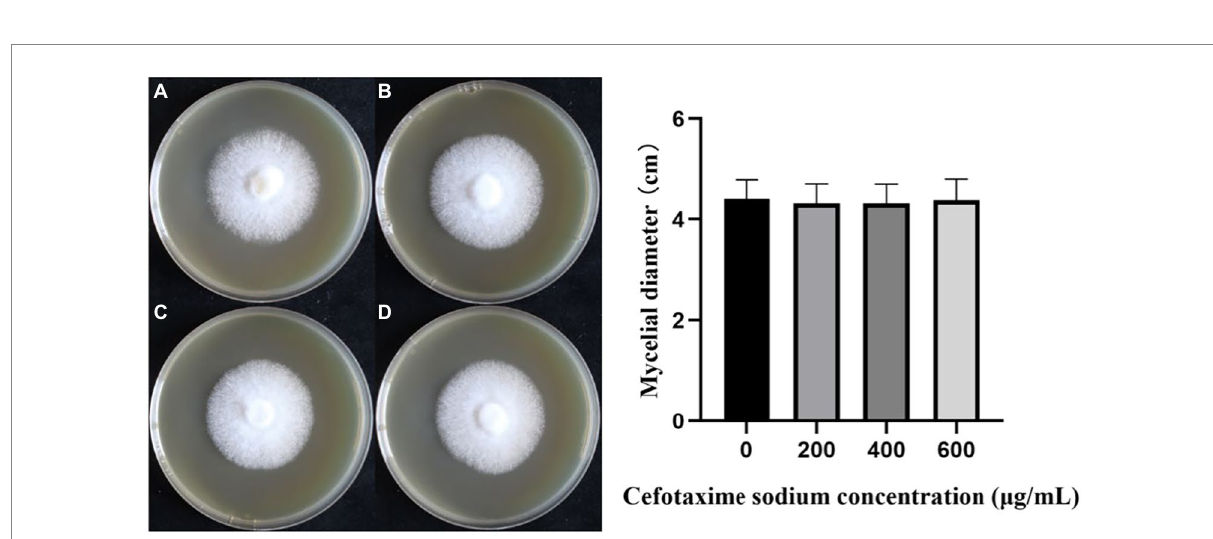
FIGURE 4 The growth of monokaryotic strain in different cefotaxime concentrations. (A–D) The concentrations of cefotaxime were 0, 200, 400, 600 μ g/ml, respectively.